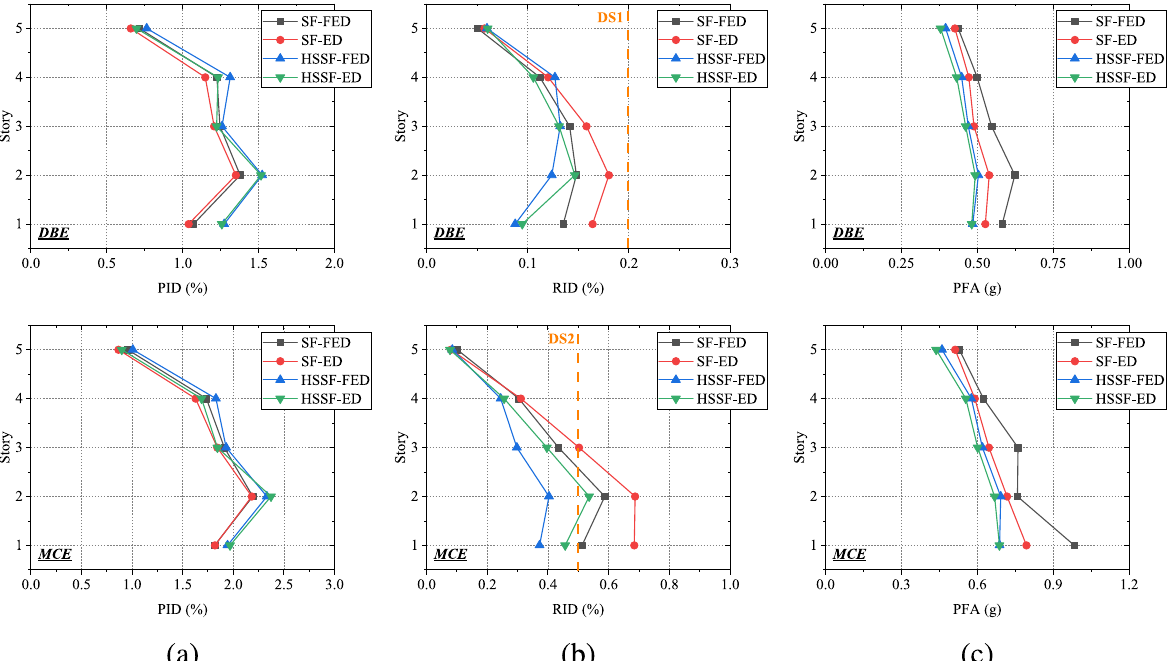
Fig. 23 Mean seismic responses of structures: a Peak inter‑story drift (PID), b Residual inter‑story drift (RID) and c Absolute floor acceleration